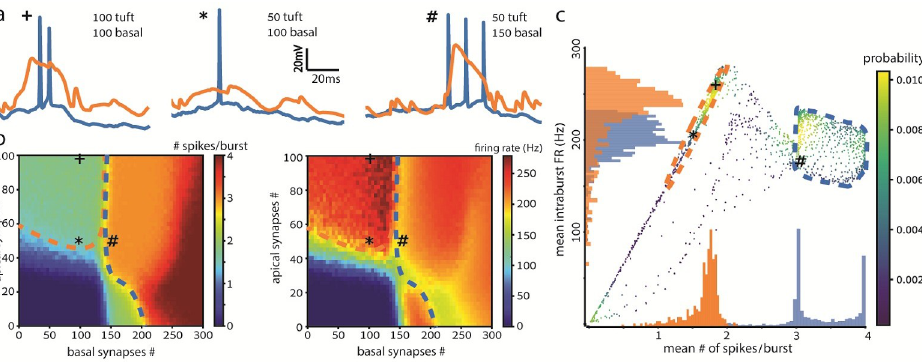
Fig 3. Two burst classes revealed based on the number of spikes per burst and intra-burst firing rate. a. Example somatic (blue) and dendritic (orange) voltage traces as in Fig 2 for the 3 cases of basal and tuft number of excitatory synapses: 100 and 100 (left), 100 and 50 (center), 150 and 50 (right). b. Heat maps of the mean # of spikes (left) and the intra-burst firing rate (right) for a range of numbers of basal and tuft synapses. The bursting threshold ( > 2 spike/burst blue-green transition) is 40–60 tuft synapses or 140–150 basal synapses. Dashed lines denote smoothed class borders. Bursts with 3–4 spikes appear only for strong basal input (within the green dashed lines). Apical tuft input above threshold results in shorter bursts of 2 spikes and higher rates (within the purple dashed lines). c. Scatter plot for each combination of synapses (x-y coordinates) in b , sorted by the mean # of spikes per burst (left frame) and the intra- burst firing rate (right frame). Each value in right-hand heat map is plotted with its corresponding value in the left- hand heat map. The color of each point in c represents the density of data points with the same values, equivalent to their probability. The purple and green histograms along the x & y-axes correspond to the data in the 2 clusters encircled in purple and green, accordingly. Temporal input parameters were fixed at Δ t = 0, σ = 10 ms.